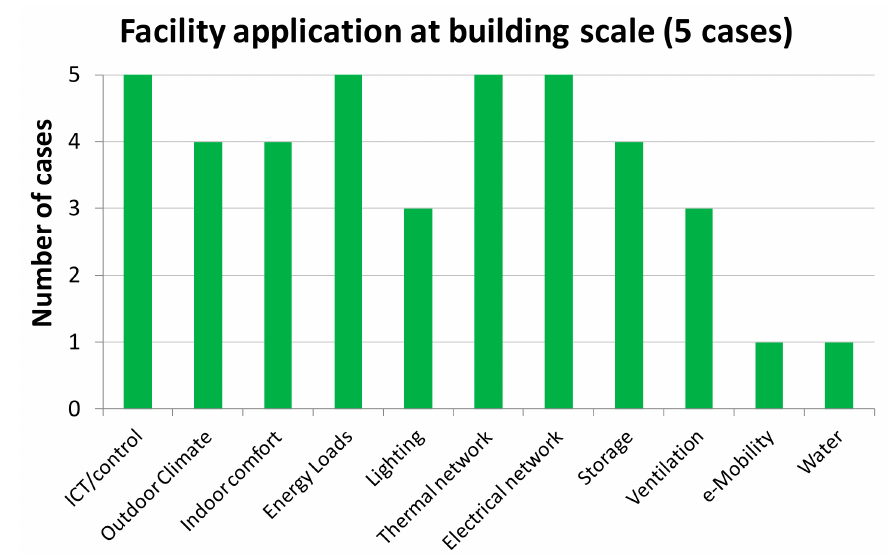
Figure 11. Histogram of occurrence obtained for the facility applications at the building